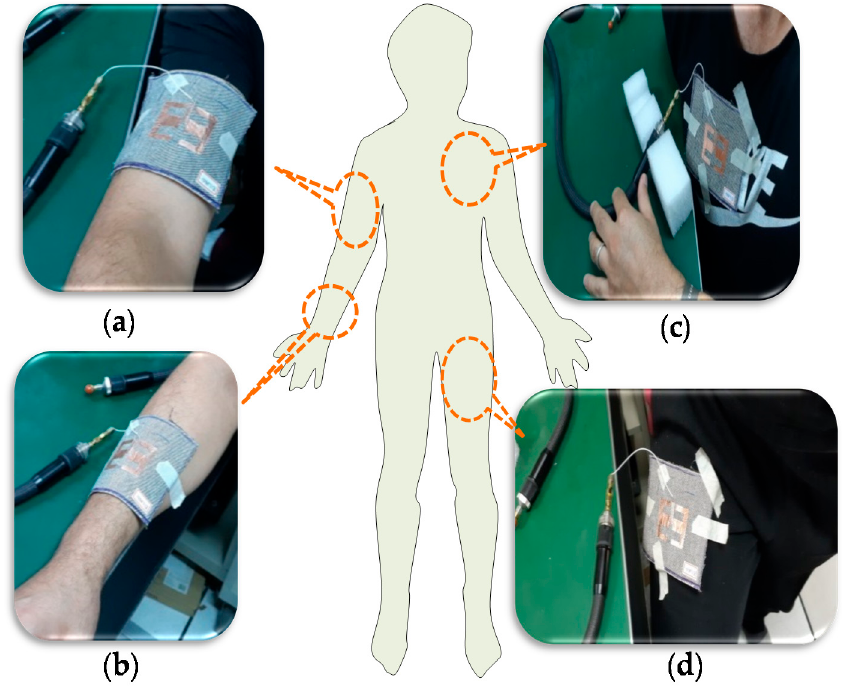
Figure 9. Photos of antenna measurements on di ff erent locations (body 1): ( a ) Arm, ( b ) Wrist, ( c ) Chest and ( d ) thigh.